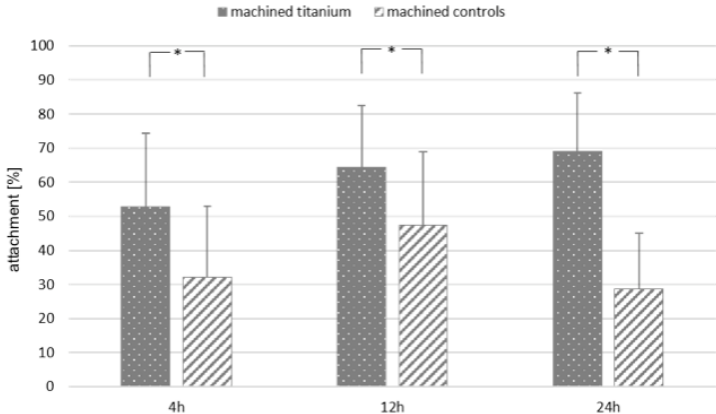
Figure 2. Comparison of relative proportion of focal adhesion (Vinculin) after 4, 12 and 24 h of fibroblast cultivation on machined titanium probes with controls. The bars correspond to the mean value, and the line on top corresponds to the ± standard deviation. Statistically significant differences ( p < 0.05) are marked with an asterisk.